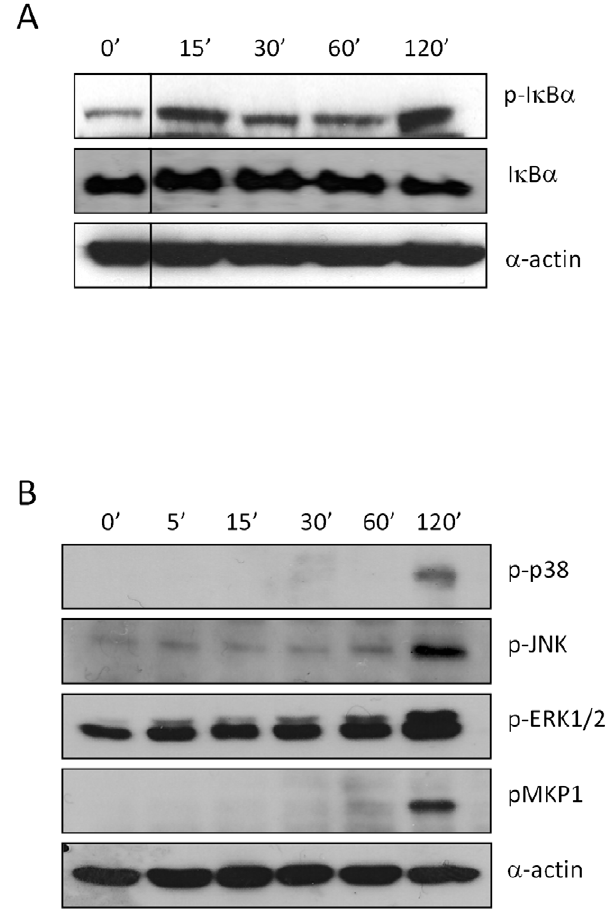
Figure 1. C.albicans infection of A431 epithelial cells activates NF- k B and MAPK signaling. C. albicans SC5314 was added to A431 vaginal ECs under standard culture conditions for 5, 15, 30, 60 min and 2 h. Total protein was isolated and phosphorylation of (A) I k B a or (B) p38, JNK, ERK1/2 and MKP1 were assessed by Western blotting. Bands are shown with an a -actin loading control. A C. albicans :EC MOI of 10:1 was used. Data are representative of three independent experiments.